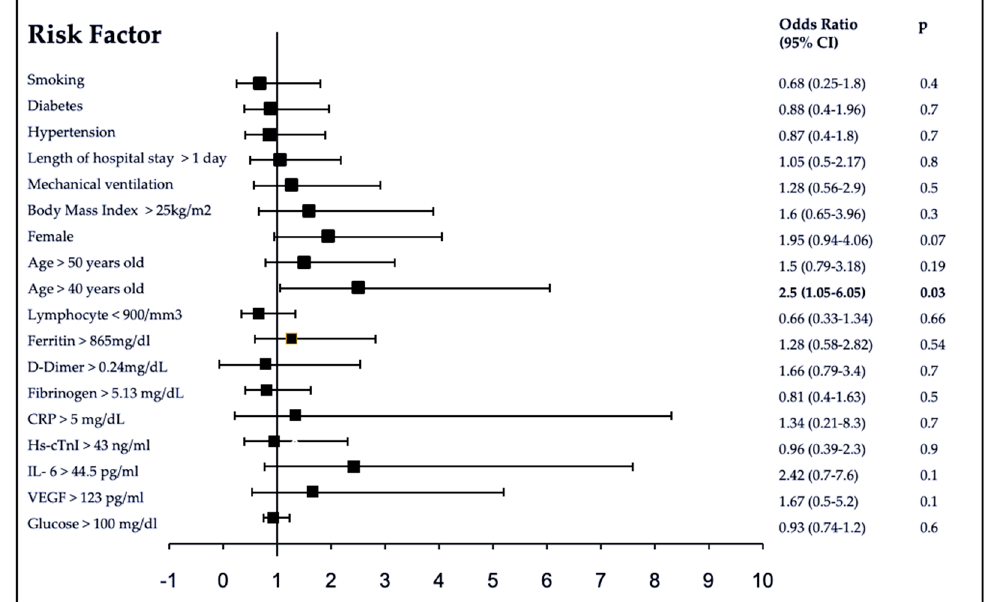
Figure 2. Associated factors in Chronic Fatigue in Post COVID-19. The 95% confidence intervals (CI) of the odds ratios have been adjusted for multiple testing. In bold, independent predictors associated with the outcomes. To the purpose of logistic regression, variables were categorized regarding their 75-percentiles or lowest levels where 25-percentiles were used of our population. C-Reactive Protein (CRP), High sensitive cardiac Troponin I (hs-cTnI), Interleukin-6 (IL-6), Vascular Endothelial Growth Factor (VEGF).